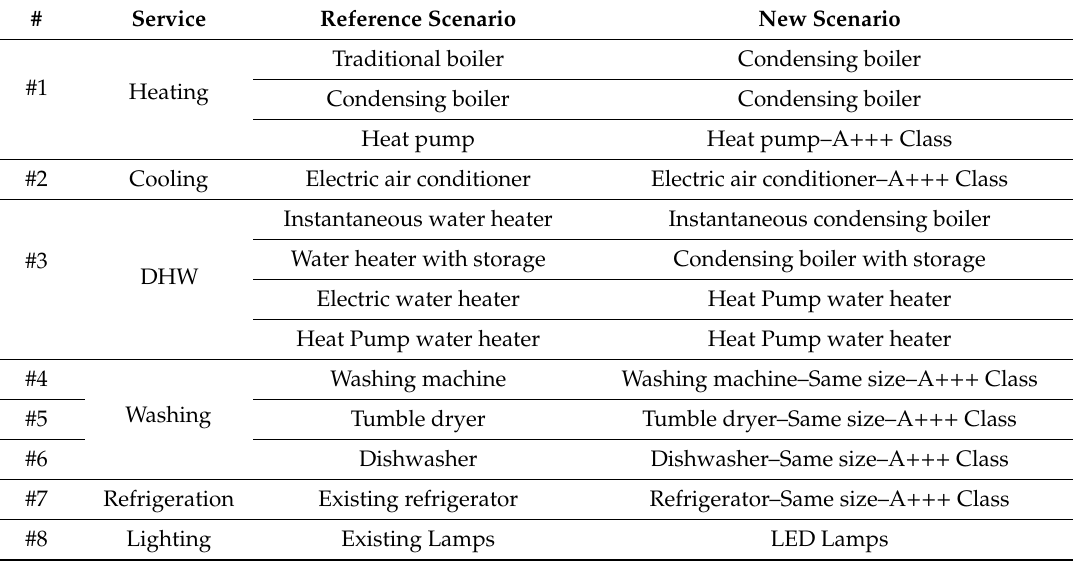
Table 4. Evolutionary